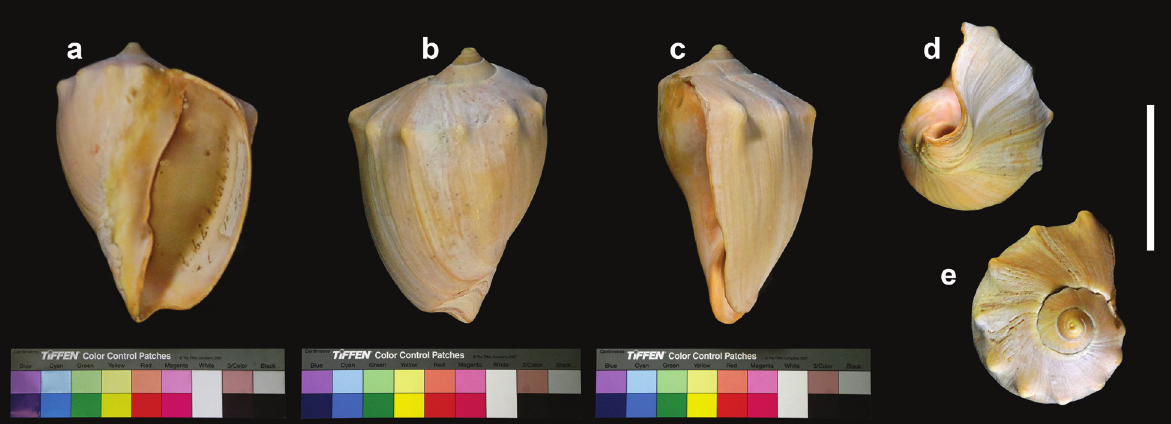
Figure 37. Voluta colocynthis subcarinata , specimen figured by Lahille (1895: pl. V, fig. 30) a Apertural view b Dorsal view c Lateral view d Umbilical view e Apical view. Scale bar: 5